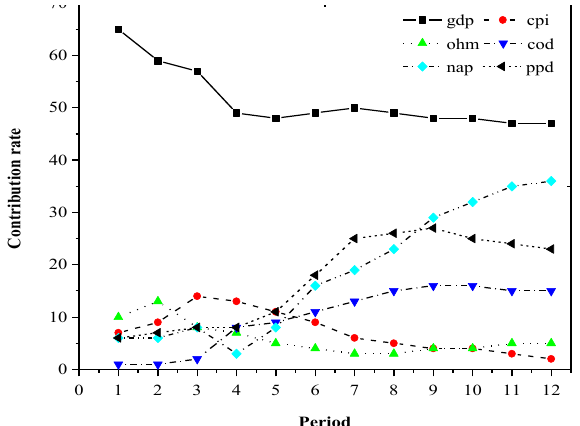
Figure 4. The decomposition of variance for